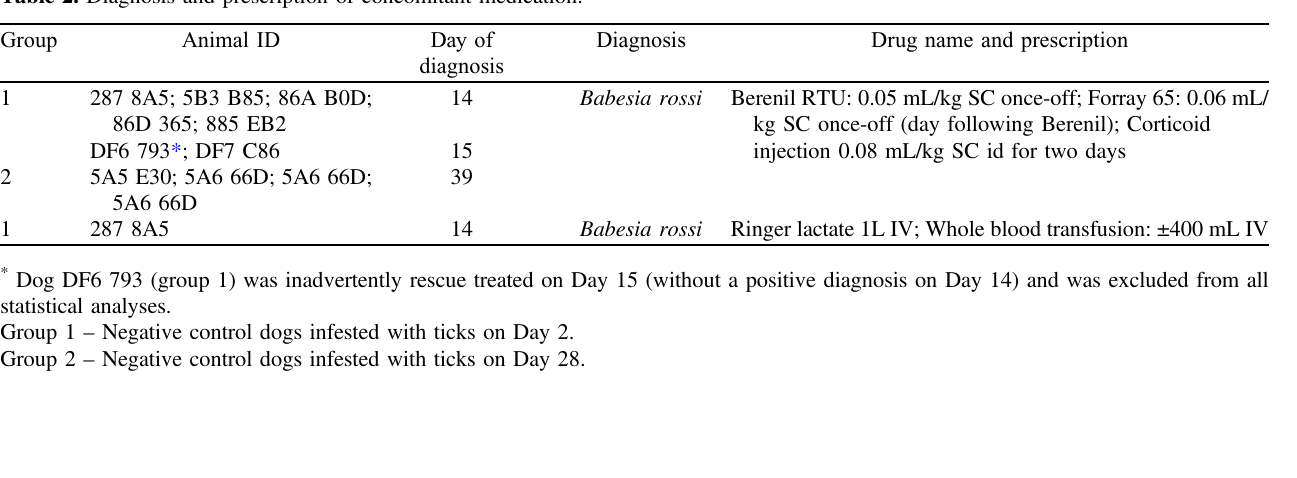
Table 2. Diagnosis and prescription of concomitant